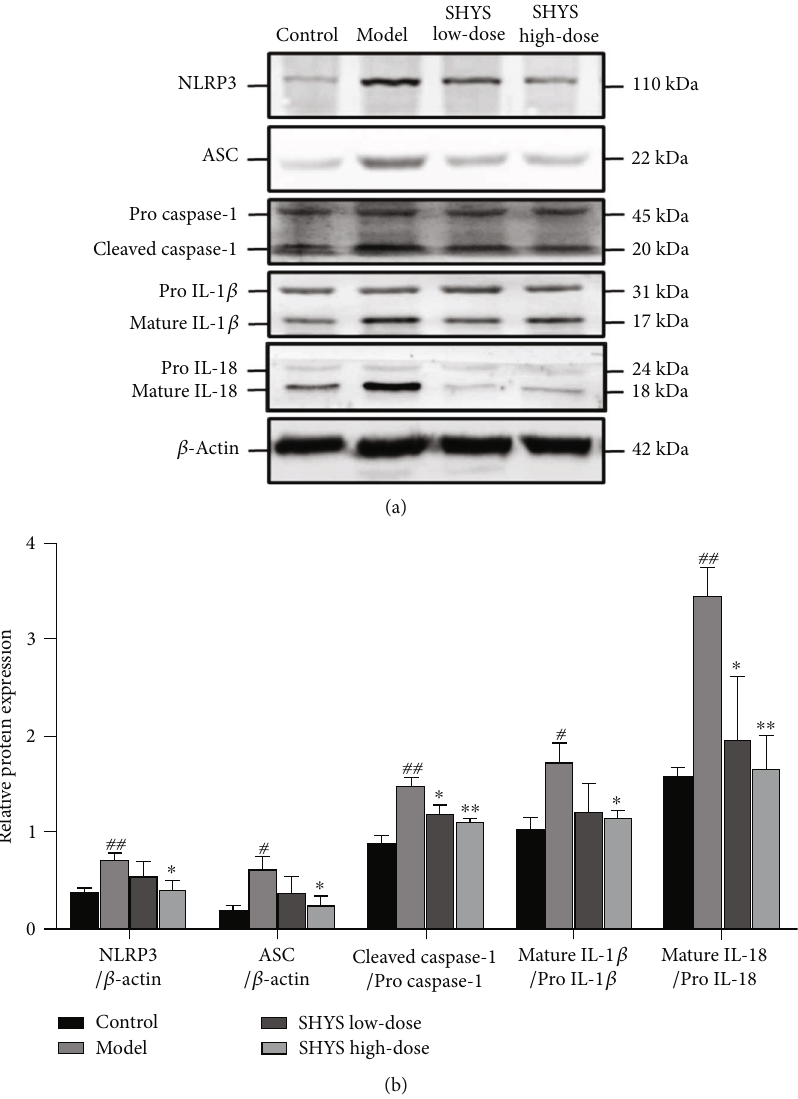
Figure 7: SHYS treatment inhibited the activation of NLRP3 signaling pathway in DKD model rats. The levels of proteins related to NLRP3 signaling pathway were detected by western blot. (a) Relative image of western blot (b) Analysis of relative protein expression based on gray